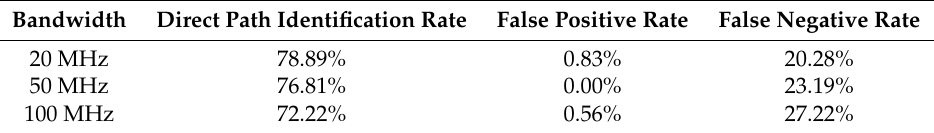
Table 4. Direct path identification rate of NC-MUSIC in UMa scenario with 20 MHz, 50 MHz and 100 MHz bandwidth.